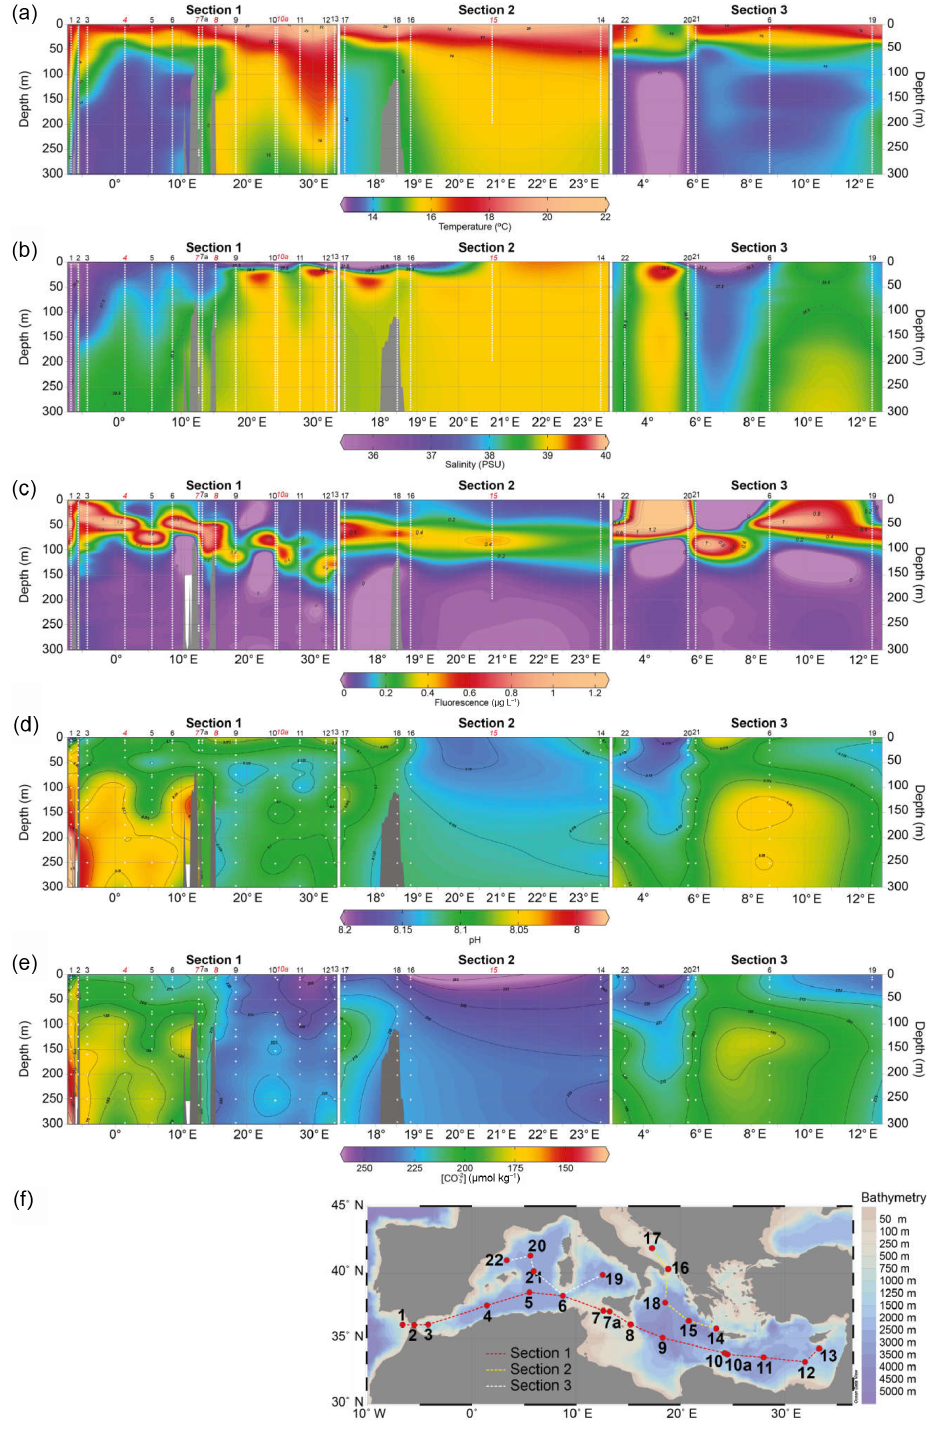
Figure 1. (a) Temperature ( ◦ C), (b) salinity, (c) fluorescence (µgL − 1 ) , (d) pH, and (e) [CO 2 − the transect. Values follow a color scale (under every graph), also values shown in the isometric lines; x axis: water depth; y axis: longitude (degrees). Measurement locations indicated with white dots, with the coinciding stations numbered at top. The station number and the map section are shown on the map (f) . For station code names see Table 1. Note reversed color scale at (d, e) . Software used: Ocean Data View (Schlitzer,